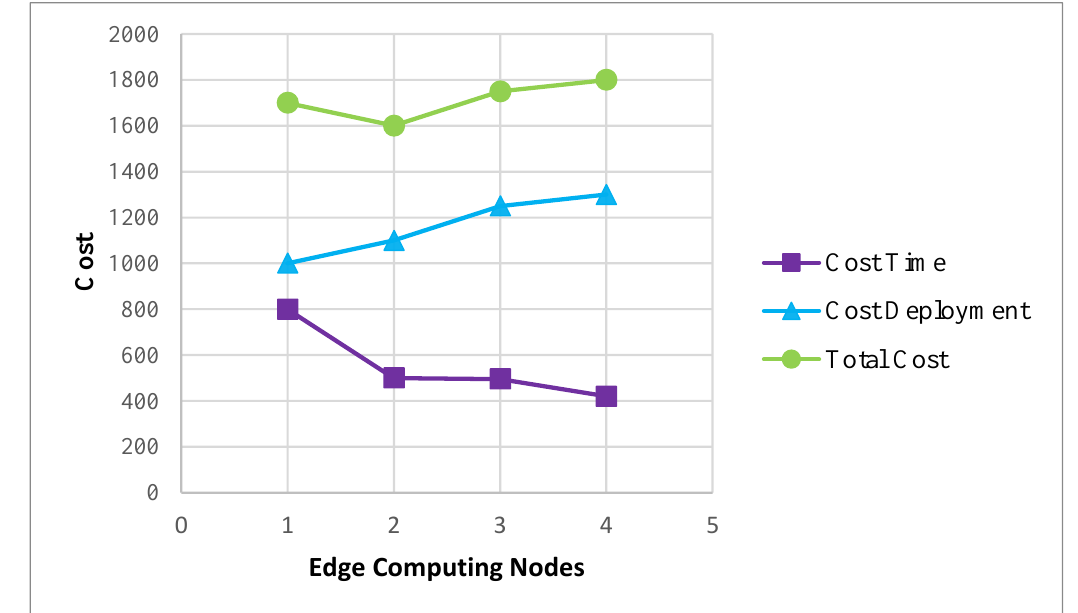
Figure 14. Total cost of IKCD and edge computing node